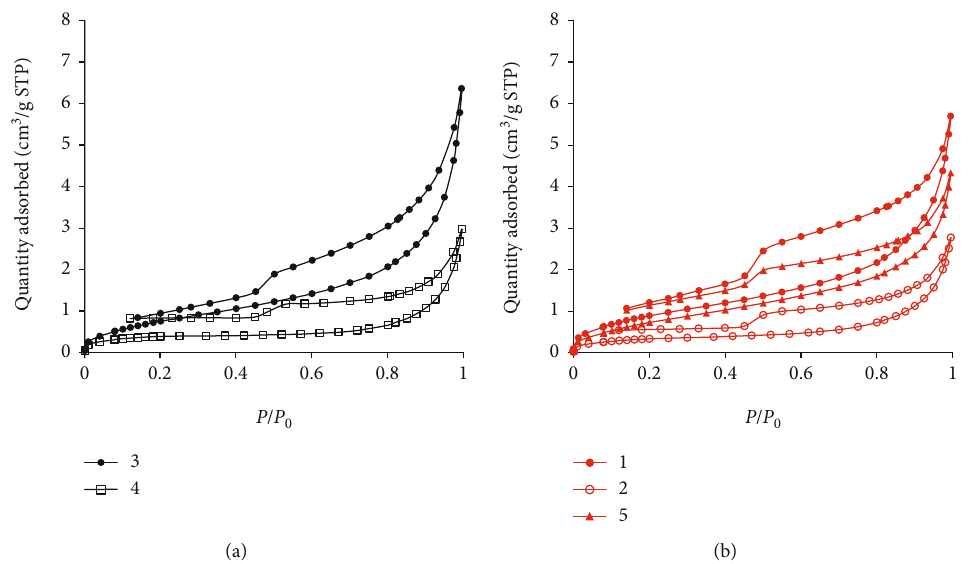
Figure 3: Nitrogen adsorption-desorption isotherms for (a) BMHS and (b) CMHS.